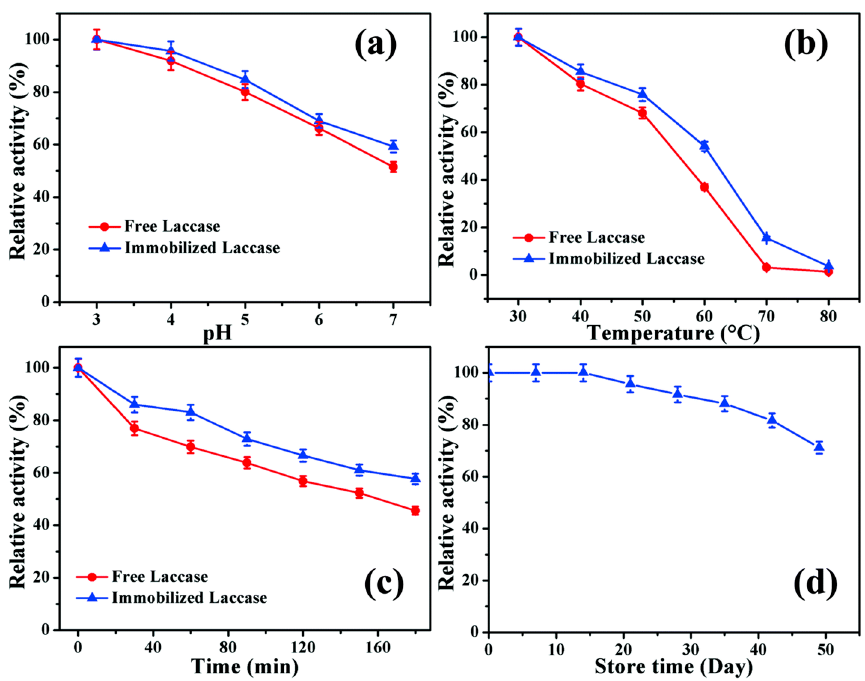
Figure 2. Catalytic activity of free laccase (red) and laccase@NH 2 -MIL-53(Al) (blue) in the oxidation of ABTS at different pHs ( a ), at different temperatures ( b ); thermal stabilities of free and immobilized laccase at 60 °C ( c ) and storage stability of immobilized laccase ( d ). Reproduced from [38] with permission from the Centre National de la Recherche Scientifique (CNRS) and the Royal Society of Chemistry.